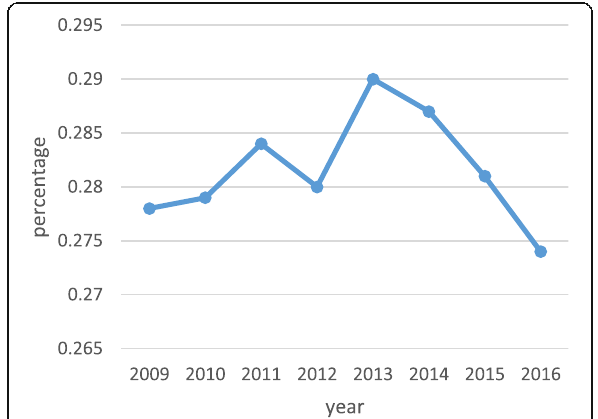
Fig. 1 The proportion of employment of the manufacturing sector in total employment